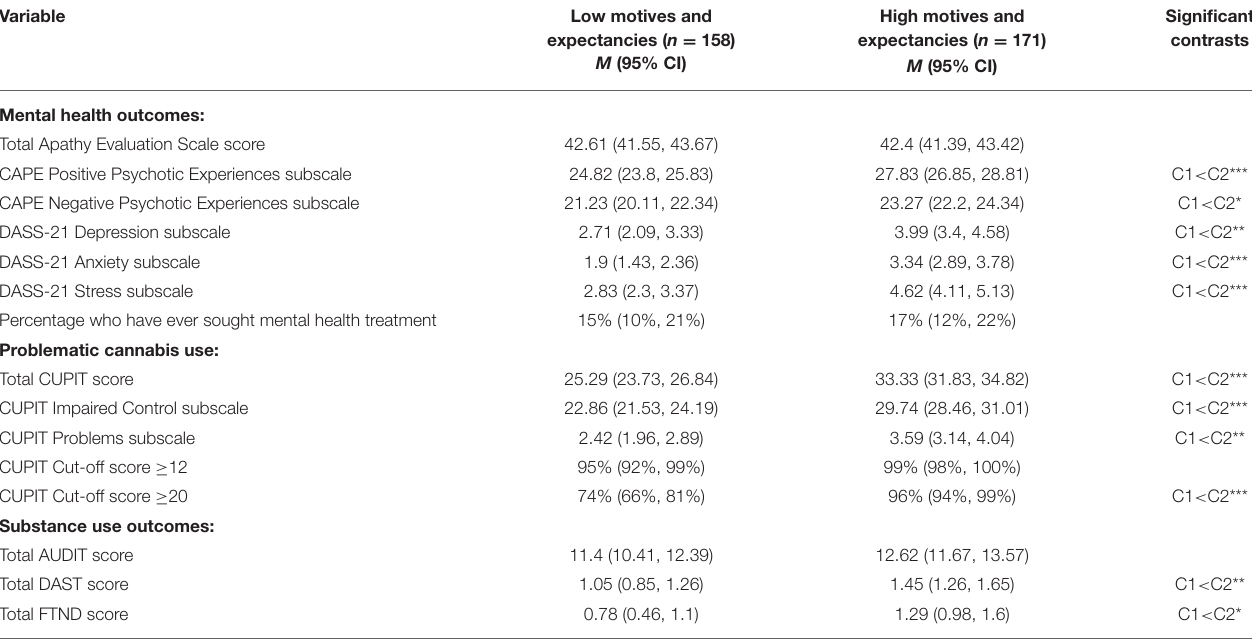
TABLE 5 | Means and confidence intervals of mental health and substance use outcome variables (2-class model) a .